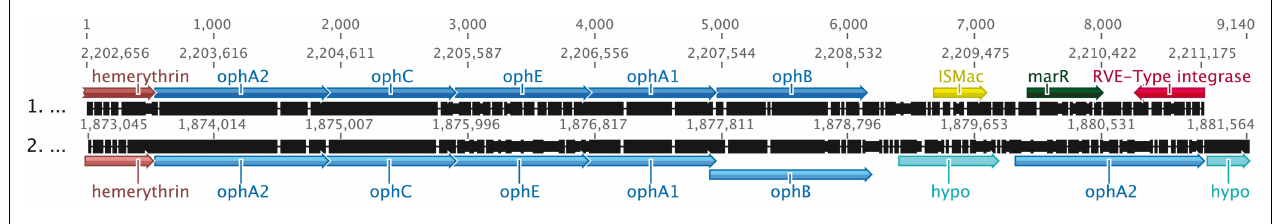
FIGURE 5 |Alignment of oph clusters from Comamonas testosteroni KF-1 (top, NZ_AAUJ02000001) and Delftia sp. Cs1-4 (bottom, NC_015563). Values across the top of the diagram indicate position (bp) within the alignment, while those above each sequence indicate position in